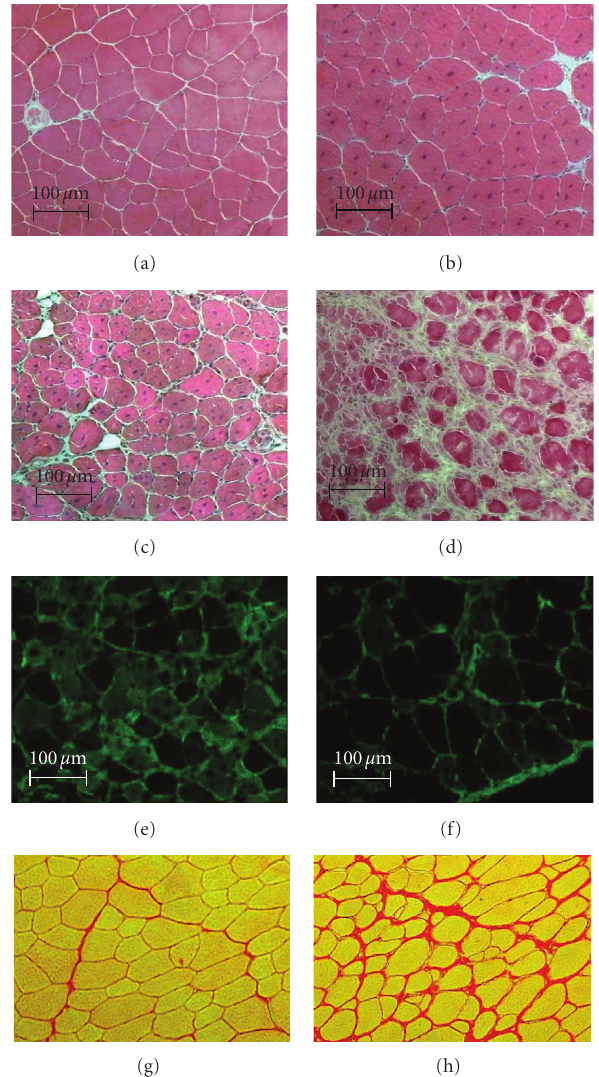
Figure 1: Cross-section of muscles after IR injury and myotoxic injury. Cross-sections 14 days after injury was stained with hematoxylin and eosin solution ((a), (b), (c), (d)) or revealed for neonatal MHC reactivity ((e), (f)). Cross-section 2 months after IR injury were stained with Sirius red stain ((g), (h)). ((a), (g)) control muscles (corresponding to myotoxin-treated muscles); ((c), (d), (e), (h)) Ischaemic/reperfused muscles (IR+); ((b), (f)) myotoxin-treated muscles